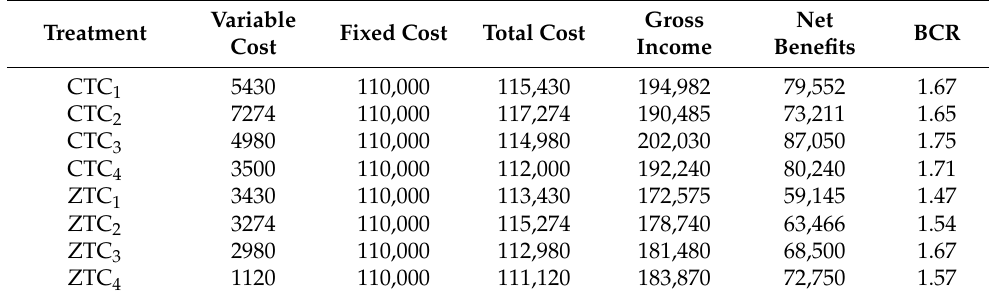
Table 5. Effect of different tillage systems and legume intercrops on the economics of the system.